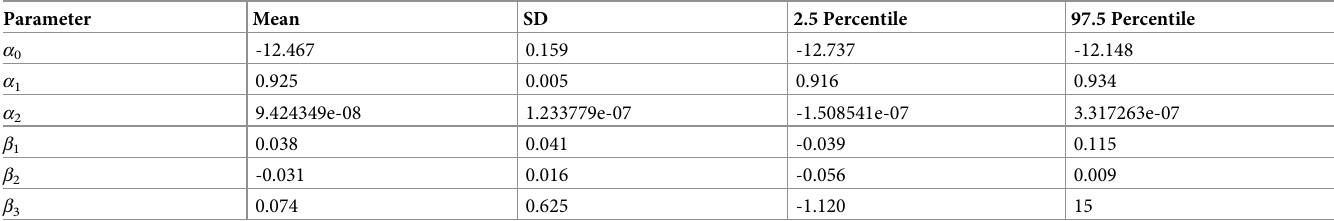
Table 9. New Jersey 3D data: Posterior mean parameter estimates for model